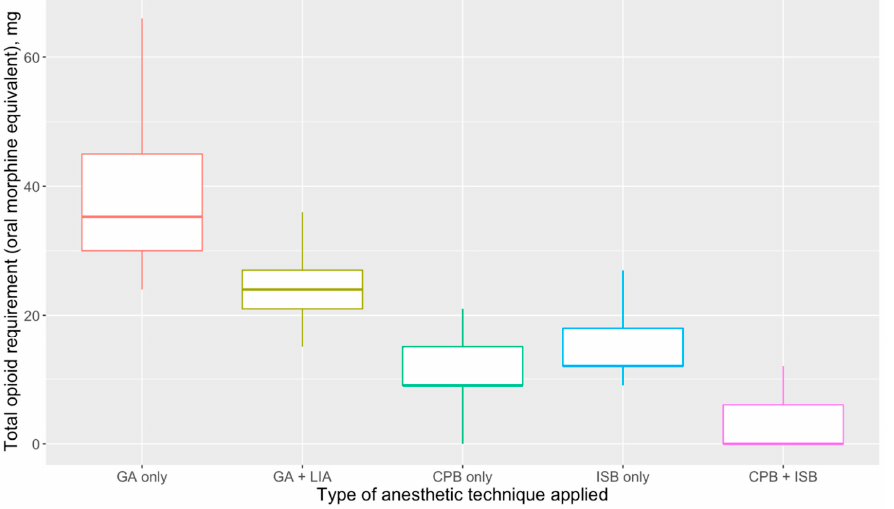
Figure 2. Comparison of total opioid requirement (in terms of oral morphine equivalents) in patients who received general anesthesia alone, compared to those who received different combinations of regional anesthesia in the intraoperative period and post-anesthetic care unit. Abbreviations: IV, intravenous; CPB, cervical plexus block; PACU, post-anesthetic care unit.